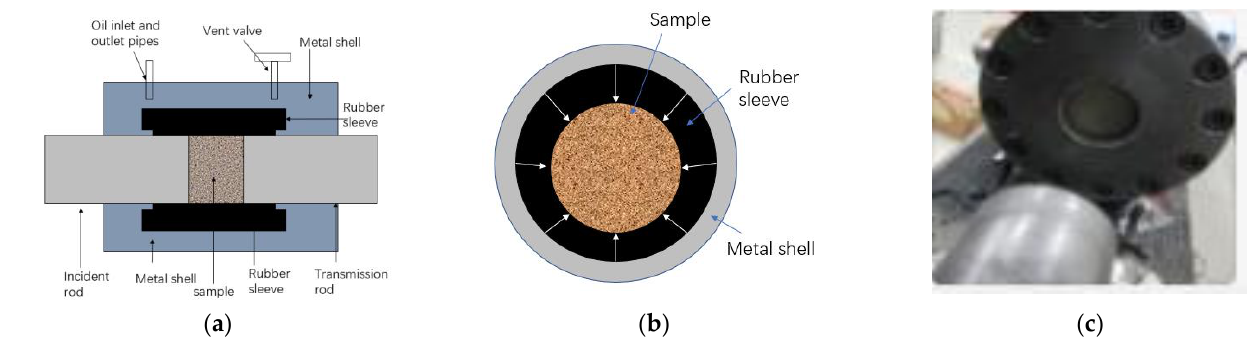
Figure 13. Uniaxial impact compression test under active confining pressure. ( a ) Active confining pressure diagram, ( b ) stress diagram of sample, ( c ) confining pressure loading device.